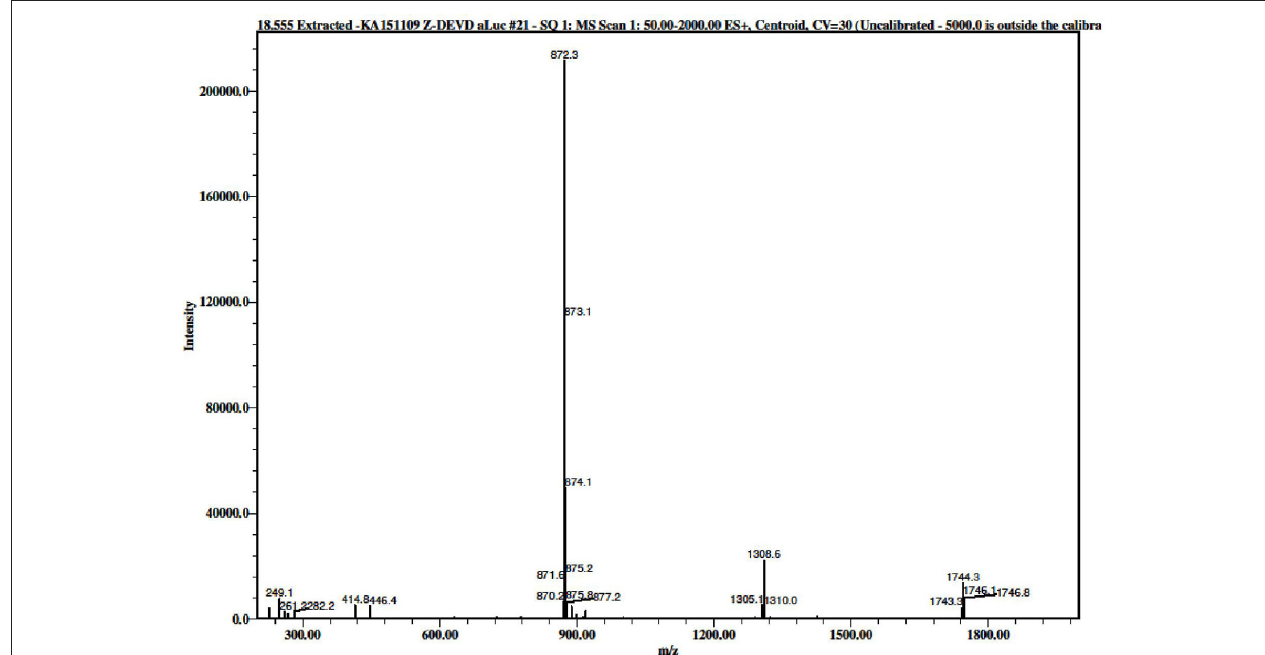
FIGURE 2 | Mass spectrum (ESI) of the purified N -Z-DEVD-aLuc (8) 872.3 = [M + H] + .